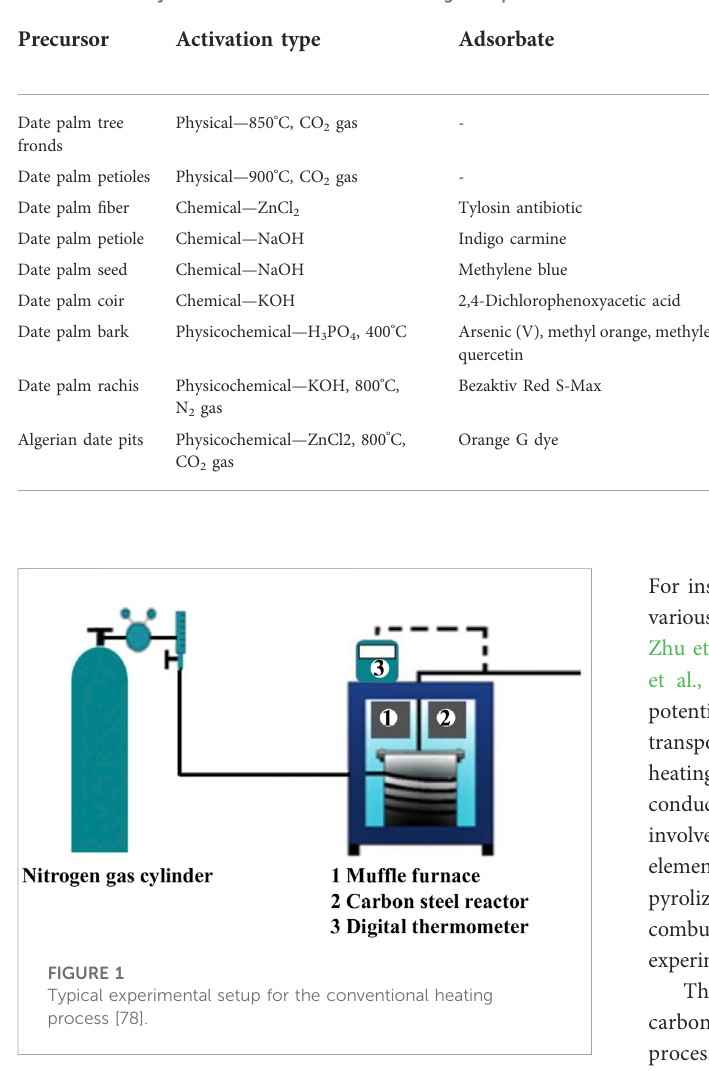
TABLE 1 Summary of works conducted in converting date palm residues into activated carbon.